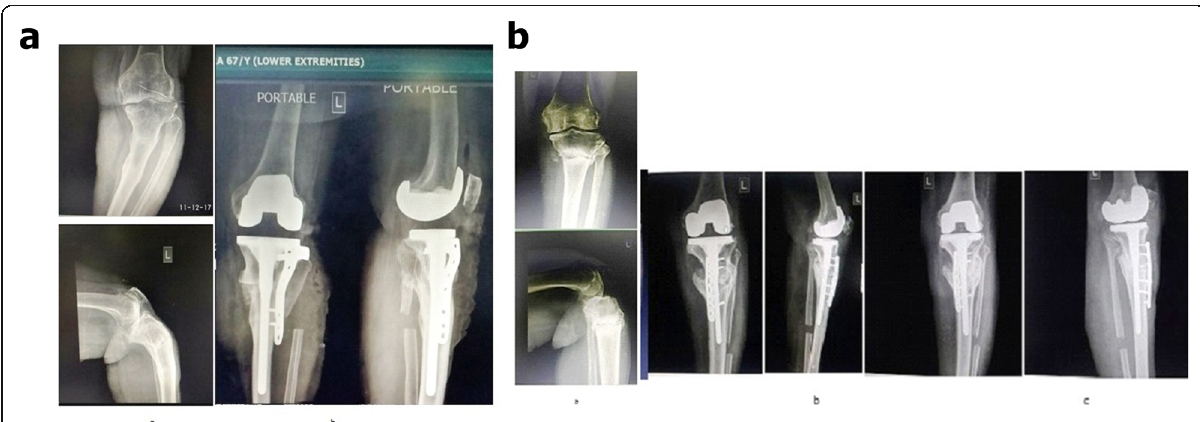
Fig. 3 a : Left Knee X-rays. a) Preoperative anteroposterior and lateral view showing features suggestive of osteoarthritis, with deformity with stress fracture of proximal tibia; b) Recent follow-up anteroposterior and lateral view showing healed stress fracture with correction of deformity with modular stemmed knee prosthesis with implant (plate) in situ with proximal fibular resection. b : Left Knee X-rays. a) Preoperative anteroposterior and lateral view showing features suggestive of osteoarthritis, with deformity with stress fracture proximal tibia; b) follow-up anteroposterior and lateral view showing healed stress fracture with correction of deformity with modular stemmed knee prosthesis with implant (plate) in situ with proximal fibular resection; c) Recent follow-up anteroposterior and lateral view showing healed stress fracture with correction of deformity with modular stemmed knee prosthesis with implant (plate) in situ with proximal fibular